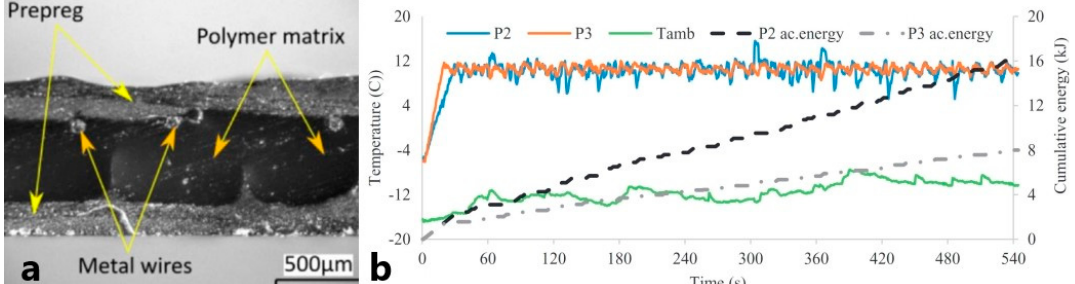
Figure 3. ( a ) Cross-section microscopic image of the 3D printed heater, ( b ) average temperature of two panels and ambient temperature with the cumulative energy of both panels (Reprinted with permission from Elsevier, copyright 2019) [45].